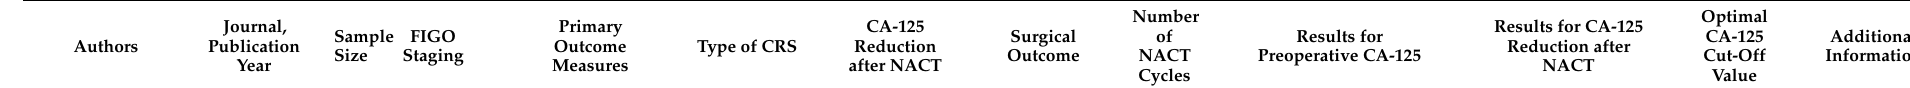
Table 1. Summary of study